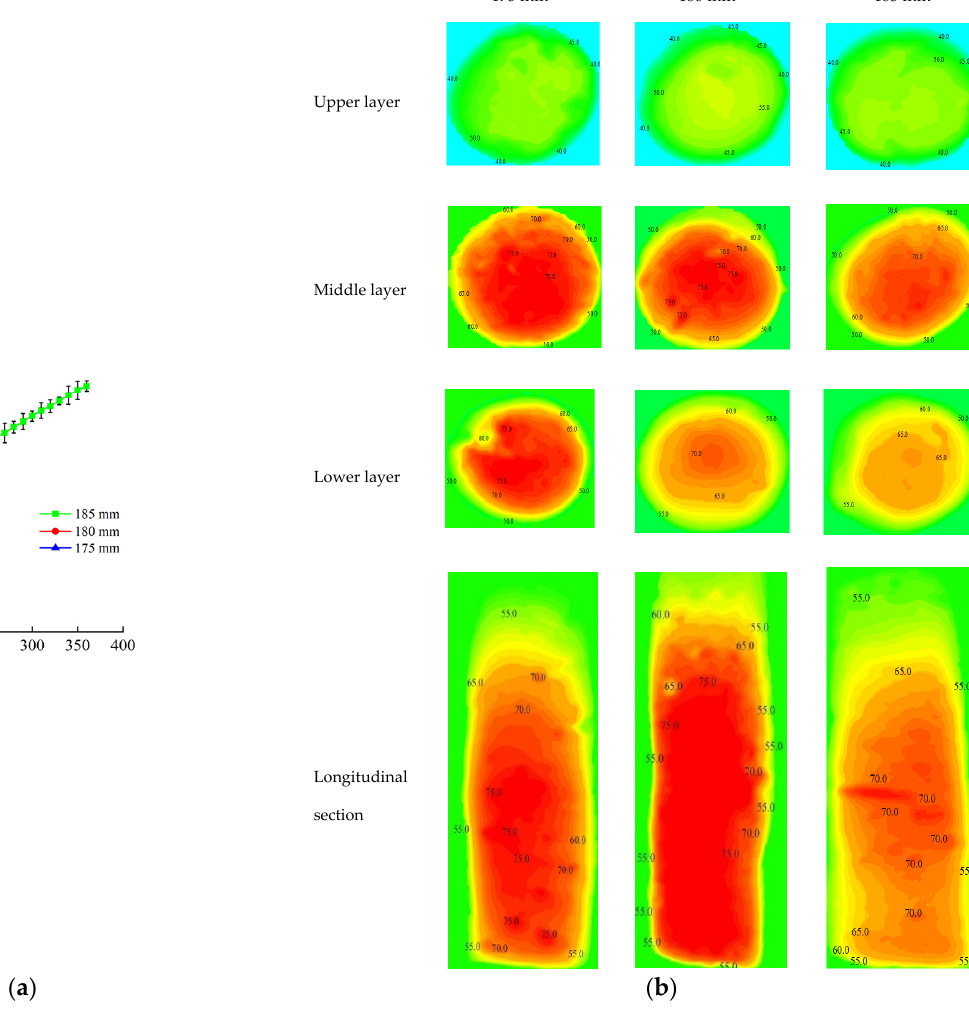
Figure 6. Time-temperature heating curves of beef sausages ( a ) and the contour plots of temperature distribution ( b ) at different electrode gaps (175, 180 and 185 mm) at a sample height of 80 mm and the temperature was initialized as 25 °C. Table 4 analyses the heating uniformity index ( 𝜆 ) values of beef sausage samples on the upper, middle and lower layers, and the longitudinal section at different NaCl (1, 2 and 3%) content with different sample heights (75, 80 and 85 mm) under different elec- trode gaps (175, 180 and 185 mm) at the initial temperature of 25 °C when applied to RF heating. The results showed that there are no significant effects ( p > 0.01) on the electrode gaps and layers, and the lowest uniformity index was obtained under the electrode gap of 180 mm. High heating rates correspond to high throughputs may cause the non-heating uniformity for the sake of rapid and runaway heating [49,50]. Thus, the electrode gap of 180 mm was chosen and used for additional research.